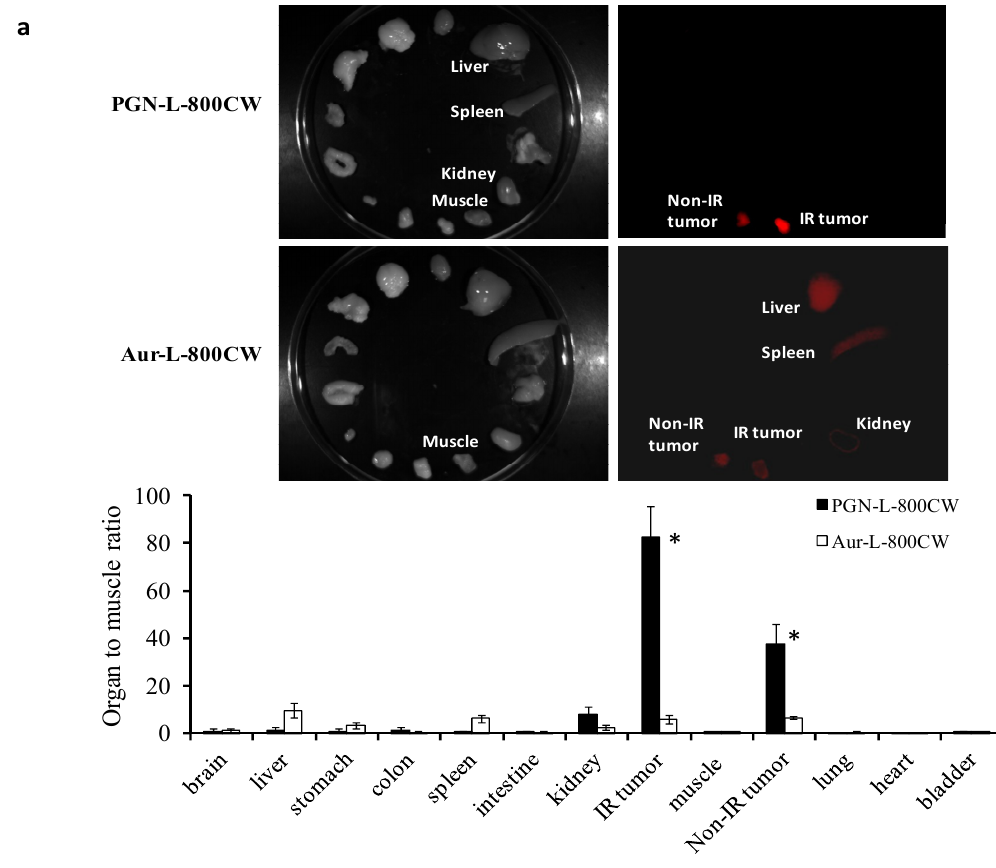
Figure 5. Ex vivo optical imaging of biodistribution of the liposomal nanoprobes. ( a ) Immediately after in vivo optical imaging at 48 h, ex vivo optical imaging was performed and average photon counts were obtained for tumors and normal organs and normalized by the muscle value; ( b ) For the mice injected with PGN-L-800CW, both the non-irradiated ( n = 5) and irradiated ( n = 5) tumors had significantly higher TMR (mean = 38 ± 8 and 83 ± 13, respectively), while the highest TMR among the normal organ/tissue was obtained from kidney (mean = 8 ± 3). Liver and spleen had a minimal accumulation. By contrast, significant amounts of the control Aur-L-800CW probes ( n = 3) were found in liver (TMR = 9) and spleen (TMR = 6). Both the non-irradiated and irradiated tumors had a mean TMR =